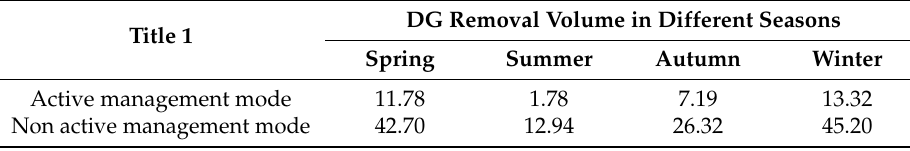
Table 3. The excision amount of active output (MW · Table 2. Optimal allocation schemes with and without active management. WG: Wind generator